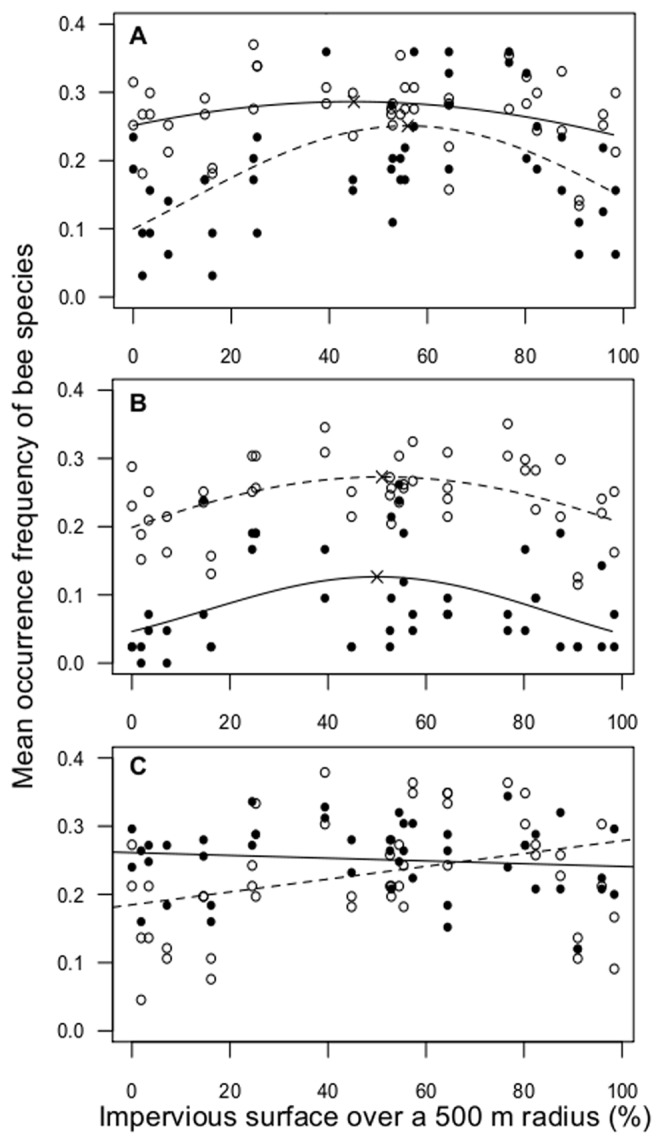
Effect of the proportion of impervious surface within 500 m on species occurrence based upon functional traits.A. Nesting behavior (filled circles and full line  =  cavity-nesting species, open circles and dashed line  =  soil-nesting species); B. Parasitic or host behavior (filled circles and full line  =  parasitic species, open circles and dashed line  =  host species) species; C. Tongue length (filled circles and full line  =  short-tongued species, open circles and dashed line  =  long-tongued species).